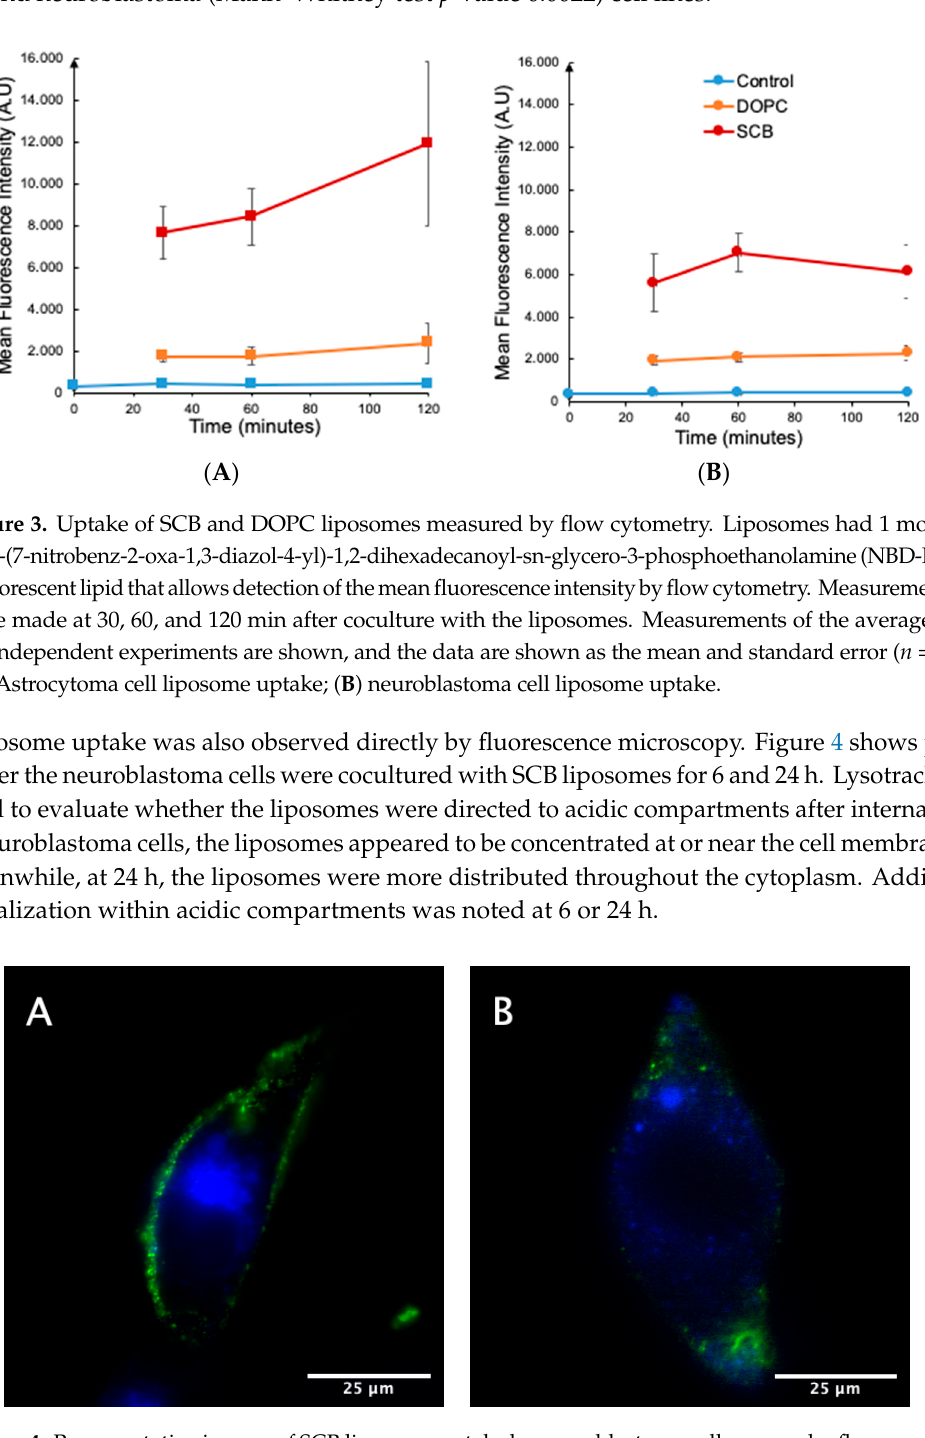
Figure 4. Representative images of SCB liposome uptake by neuroblastoma cells as seen by fluorescence microscopy. Blue represents acidic compartments, such as lysosomes, stained by Lysotracker blue. Green shows the SCB liposomes with 1 mol % of NBD-PE, a fluorescent lipid. ( A ) Photo after 6 h of coculture; ( B ) photo after 24 h of coculture. Scale, 50 µm.